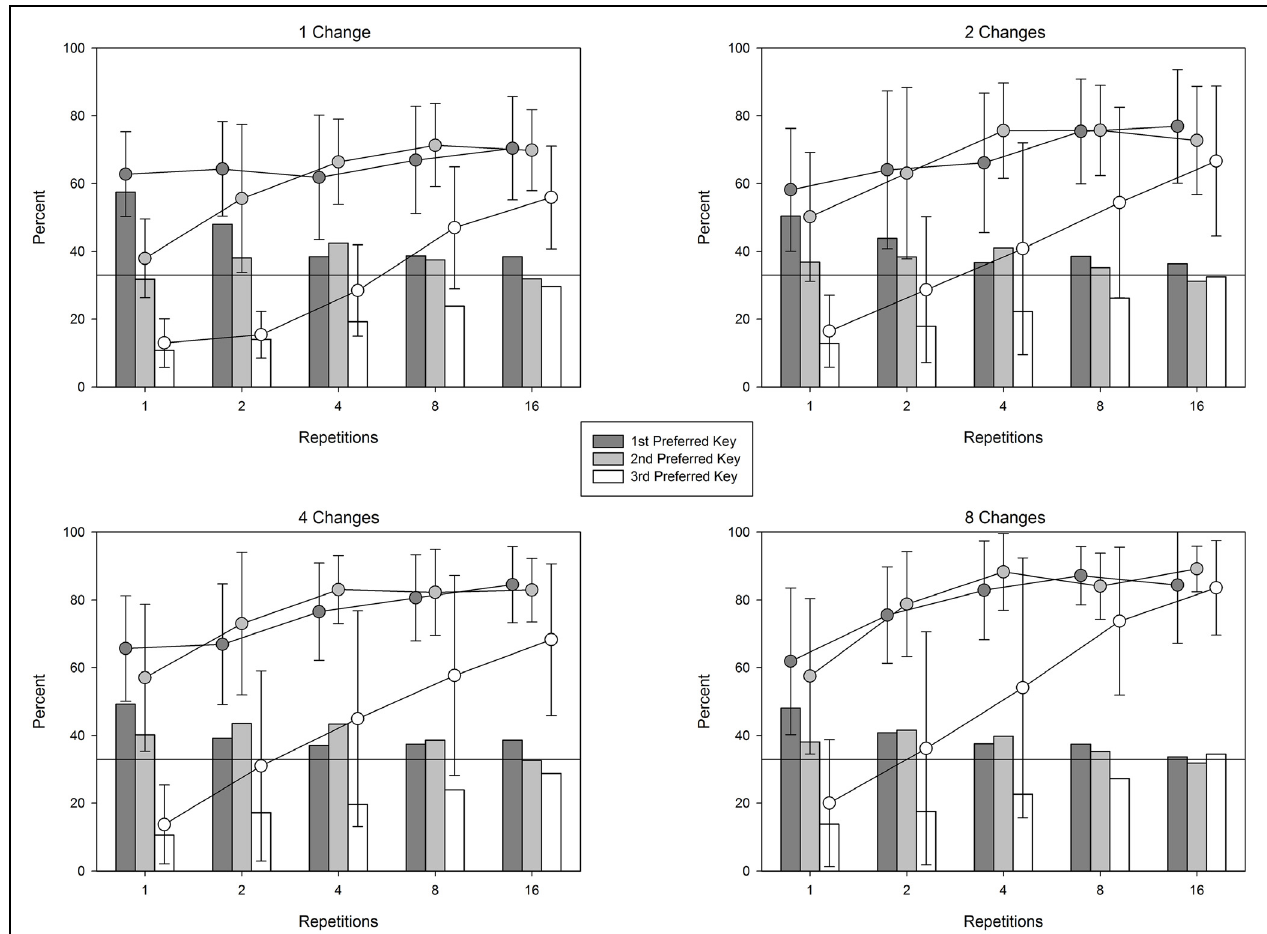
FIGURE 4 | Analysis of position bias across different numbers of repetitions and the resulting changes in performance during each condition. Vertical bars represent the percentage of choices on the first, second, and third preferred keys. Key preferences were different for each